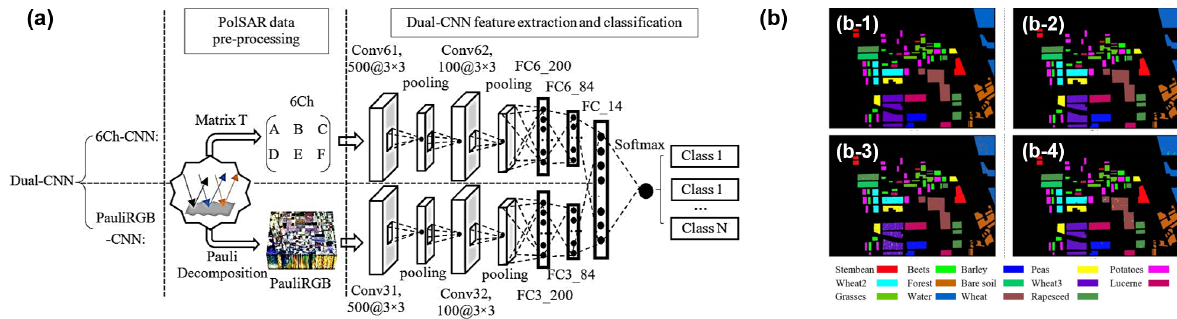
Figure 26. ( a ) The main procedures of PolSAR images classification based on the Dual-CNN model. ( b ) Comparison results with different methods, where ( b-1 – b-4 ) represent the classification results of the ground-truth, Dual-CNN, 6Ch-CNN, and PauliRGB-CNN, respectively [296]. According to the type of PolSAR image datasets, i.e., whether prior data is